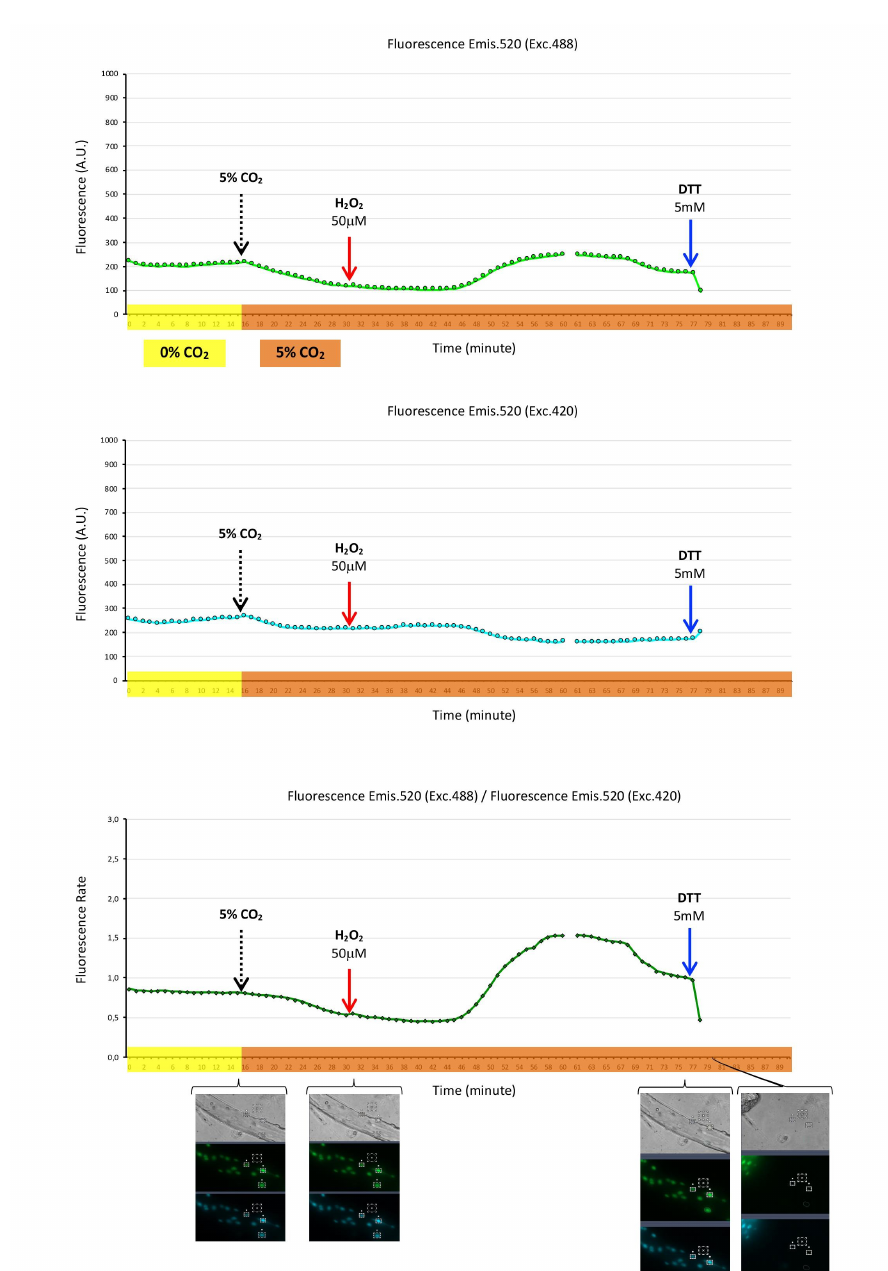
Figure 3. Hydrogen peroxide biosensor HyPer-nuc expressed in the nuclei of single skeletal muscle fibers. Nuclear fluorescence registered every minute during a 90 min time course, constituted by two consecutive time courses of 60 and 30 min. Fibers were maintained at 37 ◦ C in a 0% CO 2 atmosphere (timeline highlighted in yellow) for the first 15 min, followed by exchange to a 5% CO 2 atmosphere (timeline highlighted in orange) for 75 min. Hydrogen peroxide (50 µ M) was added to the fiber medium at the 30 min timepoint, and DTT (5 mM) at the 76 min timepoint. Top panel presents HyPer-nuc fluorescence emission at 520 nm when excited at 488 nm. Fluorescence at every timepoint is the mean of fluorescence in arbitrary units (A.U.) from three nuclei of the fiber. Middle panel presents HyPer-nuc fluorescence emission at 520 nm when excited at 420 nm. Bottom panel presents the HyPer-nuc fluorescence rate: Fluorescence emission at 520 nm when excited at 488 nm divided by fluorescence emission at 520 nm when excited at 420 nm. Sets of fiber images: Transmission (grey), green fluorescence (emis. 520, exc. 488), and blue fluorescence (emis. 520, exc. 420) at timepoints 15, 30, 76, and 79 min, where the fluorescence of the nuclei and three nuclei selected to quantify fluorescence and background fluorescence are shown. (Supplementary enlarged